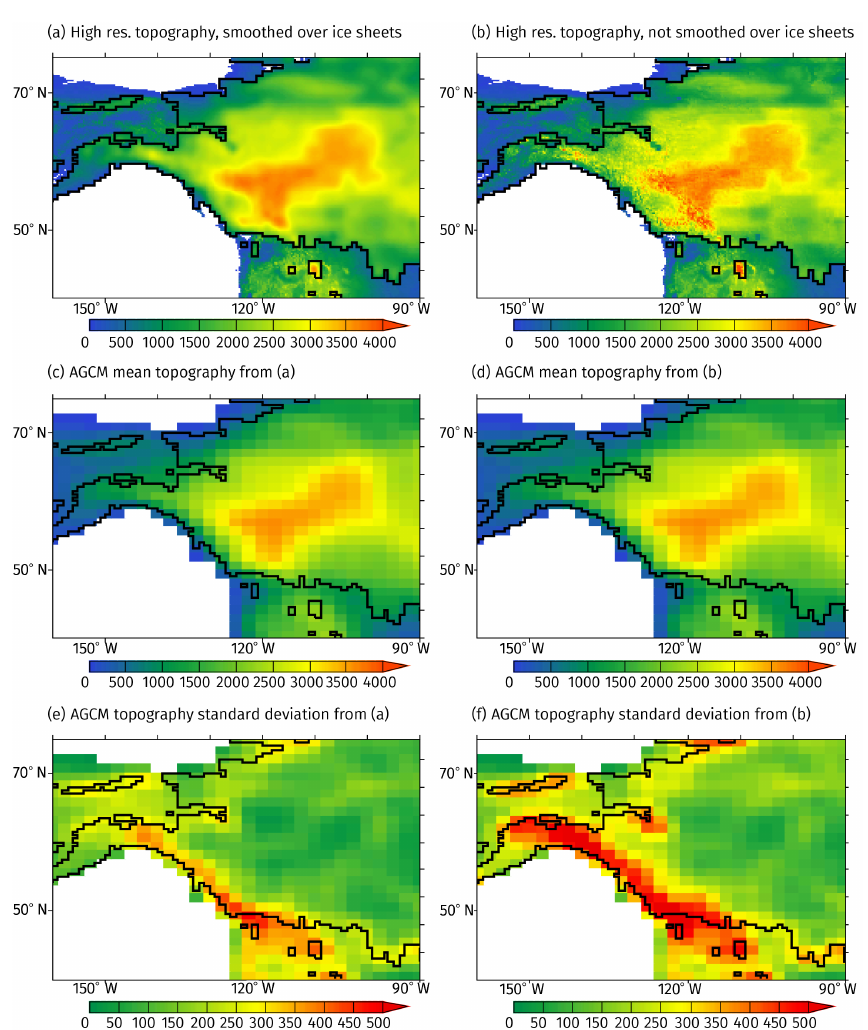
Figure 4. (a, b) High-resolution orography obtained for north-western North America, by adding the ICE_6G-C orography anomaly on the piControl orography used for the LMDZ model. (c, d) The corresponding mean altitude over each grid point. (e, f) Standard deviation of the altitude within each grid point, to represent one of the parameters used in the gravity wave drag parameterizations. (a, c, e) Without smoothing on the ice sheets; (b, d, f) after smoothing on the ice sheets. The high-resolution ocean mask is plotted in white and the land-ice mask is outlined in